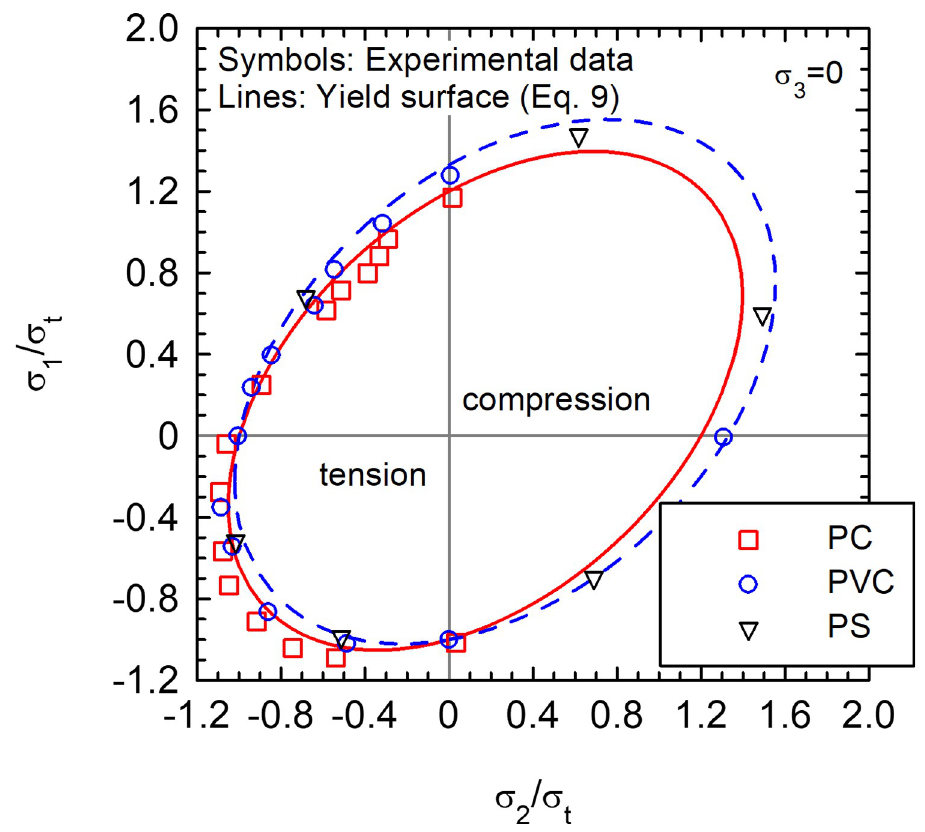
Fig 7. Fitted yield surfaces of amorphous polymers tested by Raghava et al. [24]. Polycarbonate (PC) ( σ = 0.42) [24]; Polyvinyl Chloride (PVC) ( σ c / σ t = 1.33; ν = 0.38) [24]; Polystyrene (PS)